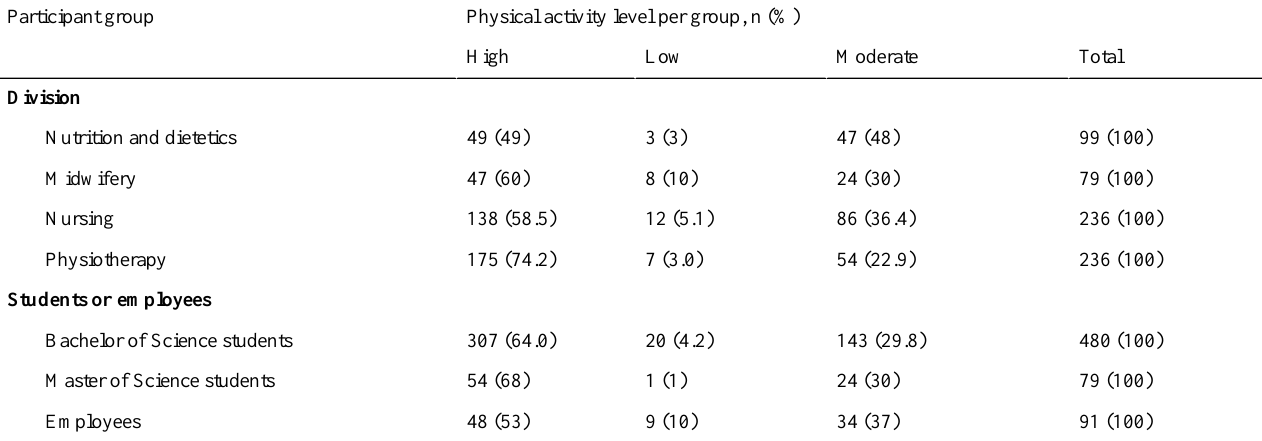
Table 1. Categorized physical activity data of the preceding 7 days of 650 students and employees in four divisions of a Swiss university of applied sciences during the spring 2020 COVID-19 lockdown.